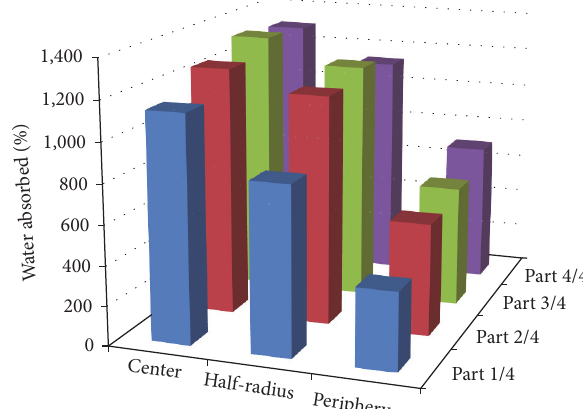
Figure 3: Distribution of the water absorption rate percentage of the pith of Raffia vinifera